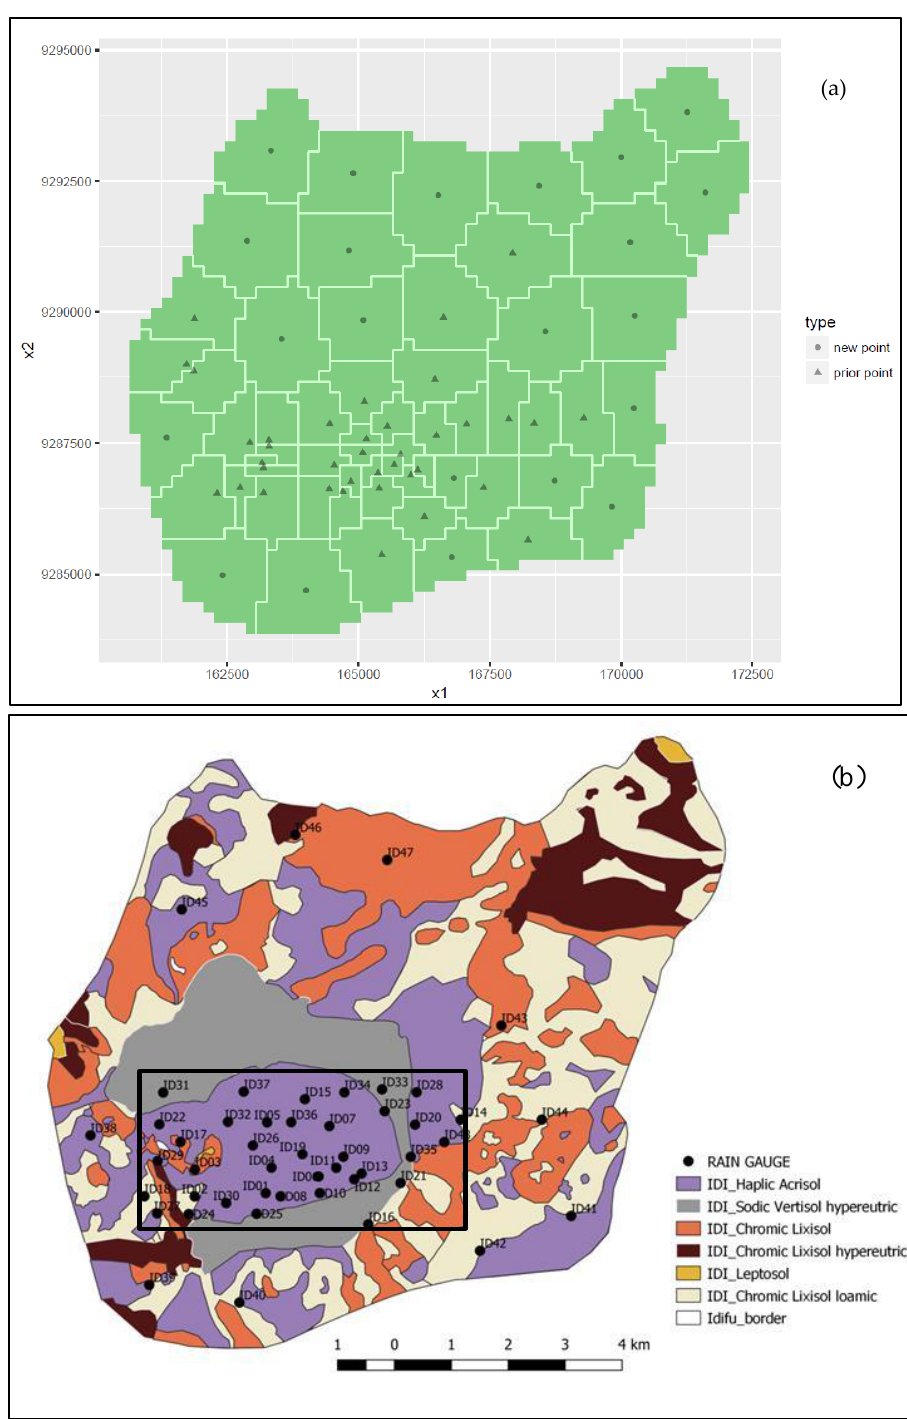
Figure 2. Rain gauges distribution representing the experimental design in Idifu village ( a ) initial design ( b ) final design after considering access and farmers ’ willingness (modified from [10]).